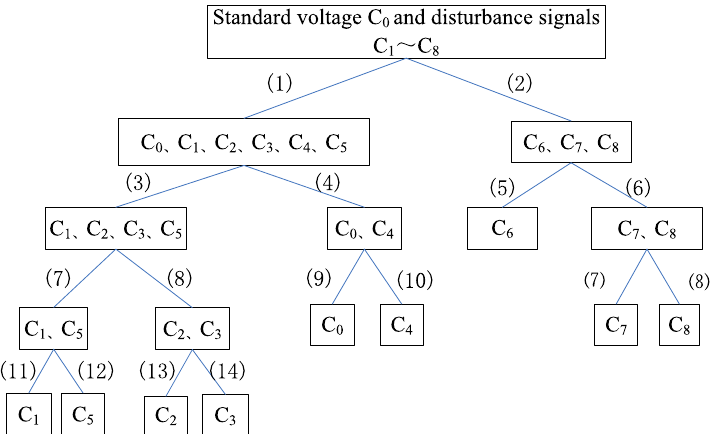
Fig. 2 Decision tree of power quality disturbance classification